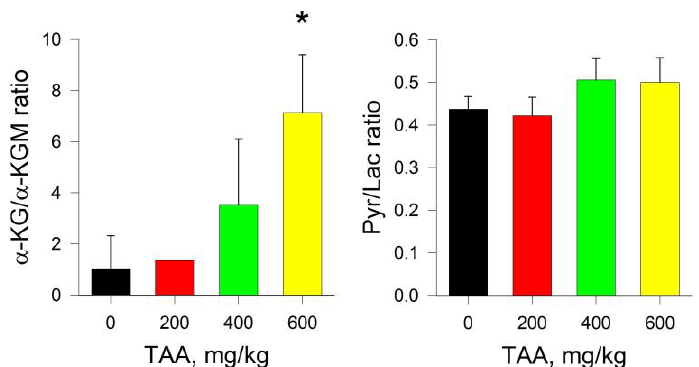
Figure 8. α - KG/α -KGM and Pyr/Lac ratios for brain tissue of control and TAA-treated rats. p -values by Tukey ’s test: * — p < 0.1; black stars mean a pairwise comparison to control (for details see Table and Figures in Supplement S1).